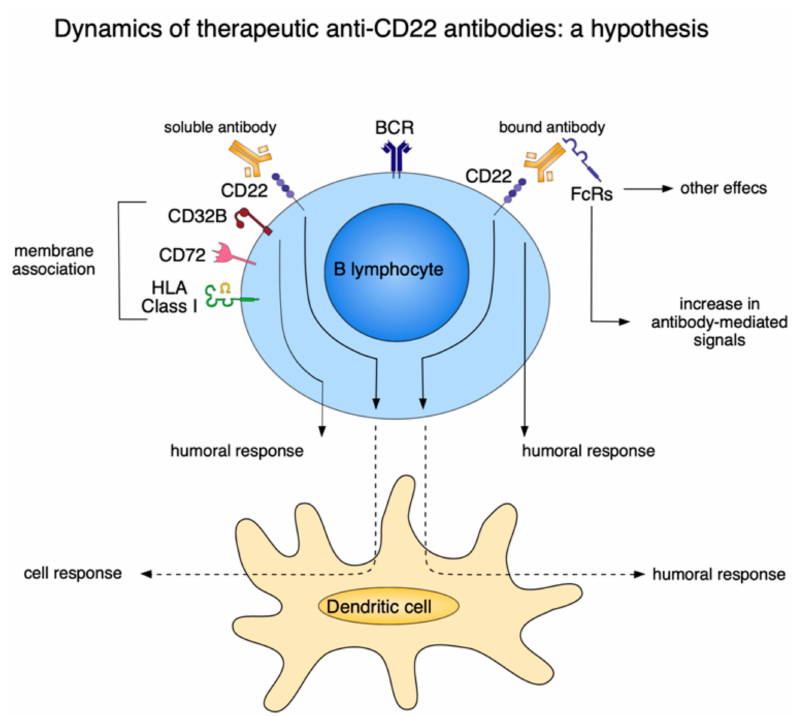
Figure 4. Hypothetical view of the e ff ects induced by the interaction of CD22 with specific antibodies. CD22 can be bound by soluble antibodies as well as by FcR-insolubilized antibodies. When CD22 ligation by a soluble antibody occurs, the interaction with other molecules closely located on the same membrane micro domain (CD32B, CD72, and HLA Class I, among others) may induce humoral as well as a dendritic cell-mediated responses. When CD22 is bound by the insolubilized antibody, this lead to an increase of antibody-mediated signals on the FcR + cells. A consequence is that CD22 might be involved in the modulation of a humoral response by lymphocytes and dendritic